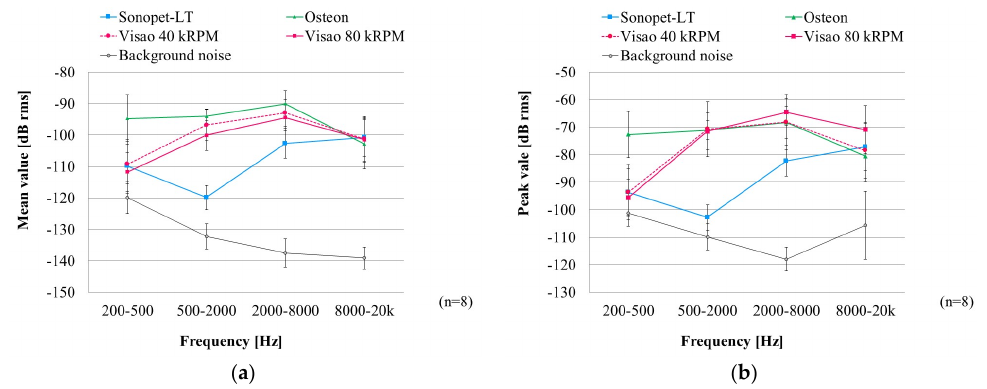
Figure 10. ( a ) Mean values for vibration levels. ( b ) Peak values for vibration levels.